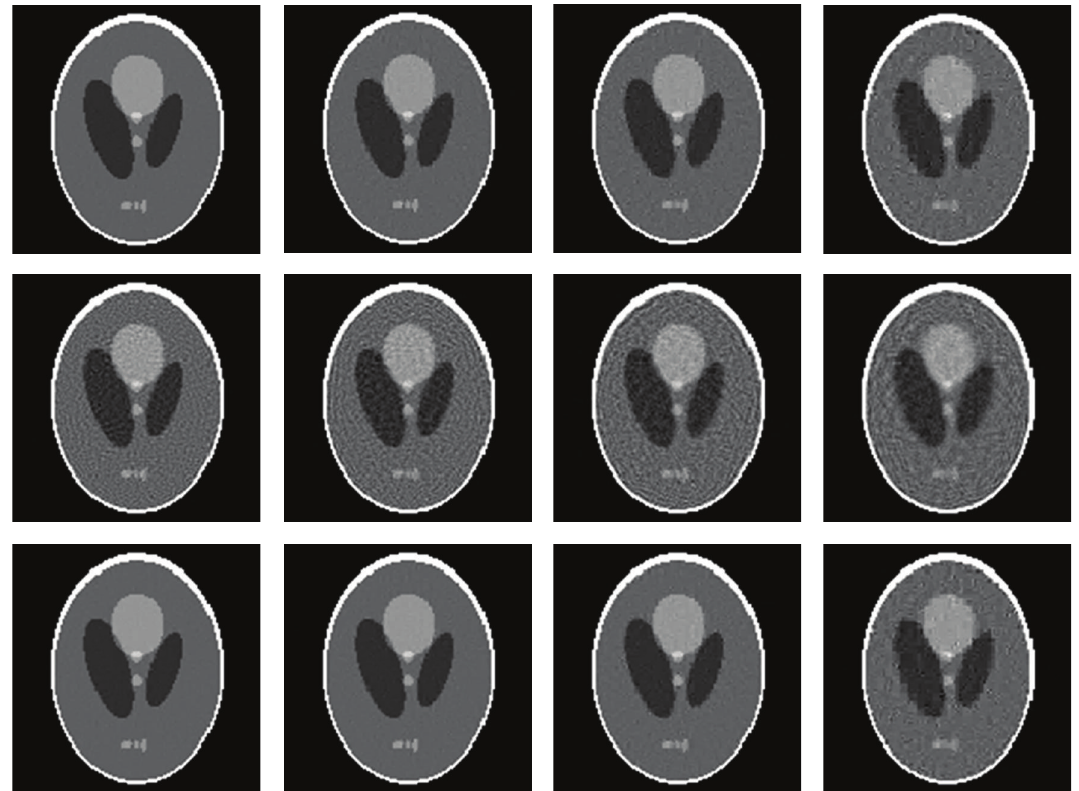
Figure 5: Counterpart of Figure 3 in the case of noisy projection